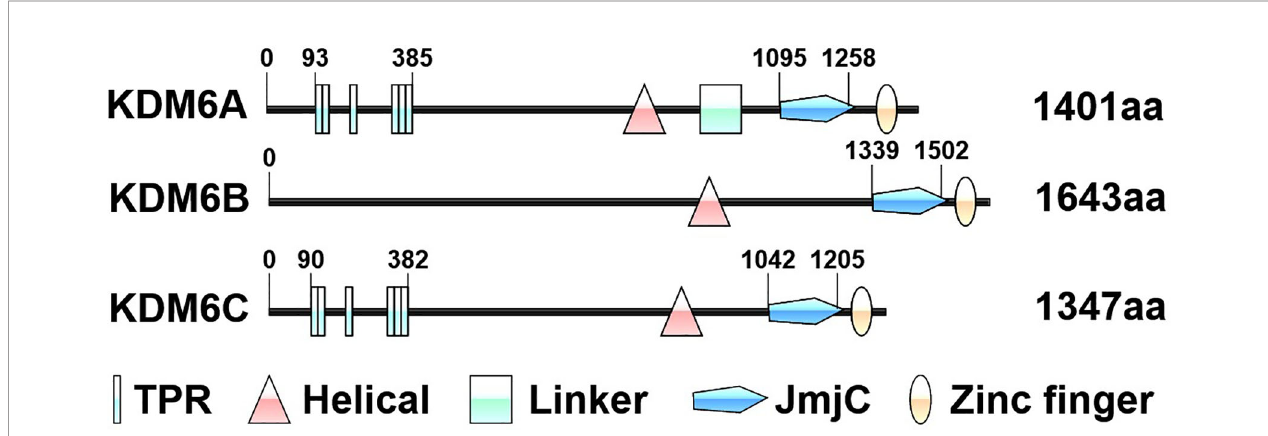
FIGURE 1 | Schematic representation of the protein domains of KDM6 enzymes. The structure of KDM6 members consists of fi ve regions: tetratricopeptide repeat domain (TPR), helical domain, linker region, Jumonji C (JmjC) domain and zinc fi nger domain. The numbers indicate the amino acid residues. The domains are based on the UniProt database